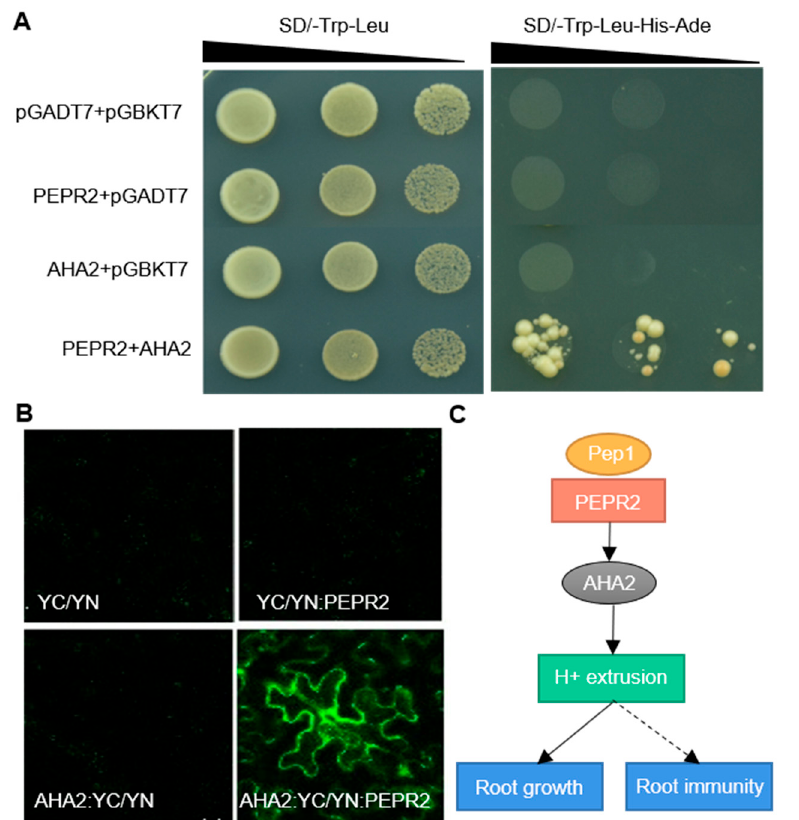
Figure 5. PEPR2 interacts with AHA2. ( A ) Yeast two-hybrid assay of protein interaction between PEPR2 and AHA2. Saturated cultures were spotted onto synthetic dropout (SD)-Trp-Leu and SD-Trp-Leu-His-Ade at di ff erent dilutions (10 − 1 , 10 − 2 , and 10 − 3 ). The co-transformants of the empty vectors pGADT7 and pGBKT7 were employed as negative controls. ( B ) Bimolecular fluorescence complementation of pSPYCE(M) / pSPYNE(R)173 (YC / YN), pSPYCE(M) / pSPYNE(R)173: PEPR2 (YC / YN:PEPR2), AHA2: pSPYCE(M) / pSPYNE(R)173 (AHA2:YC / YN), and AHA2: pSPYCE(M) / pSPYNE(R)173: PEPR2 (AHA2:YC / YN:PEPR2) Images were taken using confocal laser scanning microscopy. Bars = 50 µ m. ( C ) A proposed model of the Pep1-PEPR2 signaling pathway activates the PM H + -ATPase in roots.